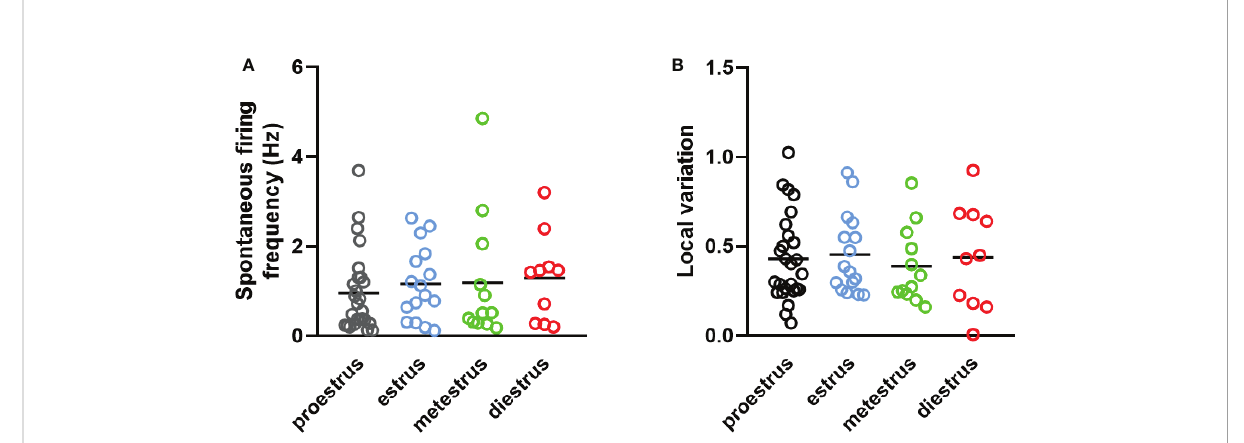
FIGURE 7 The effect of estrous cycle on spontaneous fi ring of striatal cholinergic interneurons in adult female mice. The frequency and the local variation of spontaneous activity in cholinergic interneurons in different phases of estrous cycle are presented in Panels (A, B) , respectively.